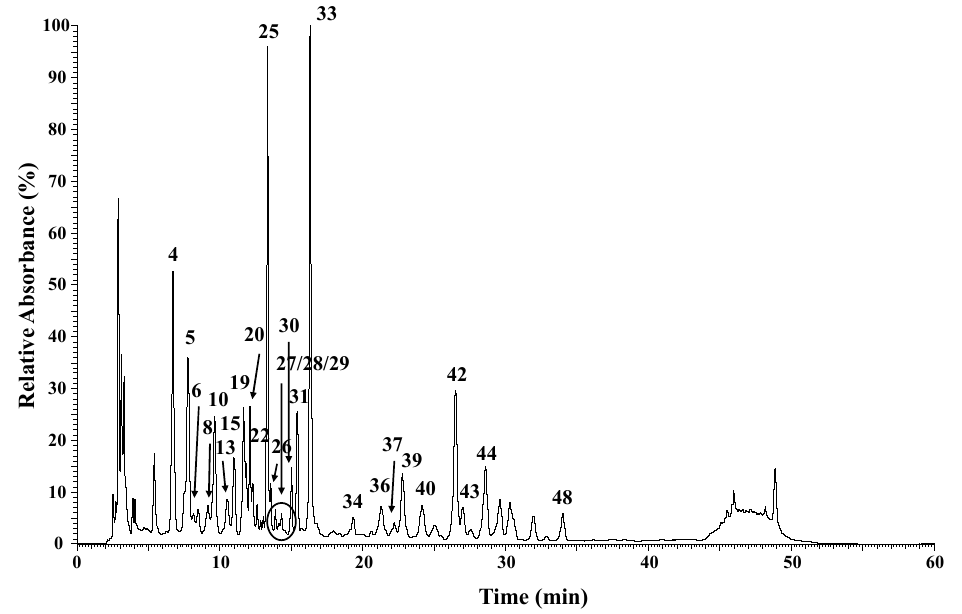
Figure 2. Chromatographic profile at 280 nm for BP6 phenolic extract.